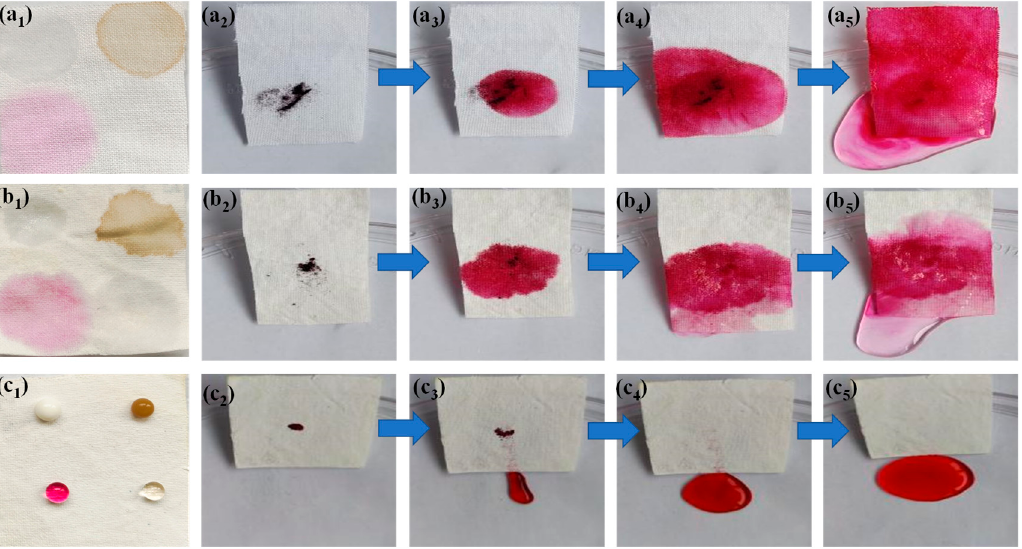
Figure 11. Photographs of antifouling ability test and self-cleaning property test for pristine cotton fabric ( a 1 –a 5 ), CS/APP cotton fabric ( b 1 –b 5 ) and CS/APP@TiO 2 -SiO 2 -HMDS cotton fabrics ( c 1 –c 5 ).